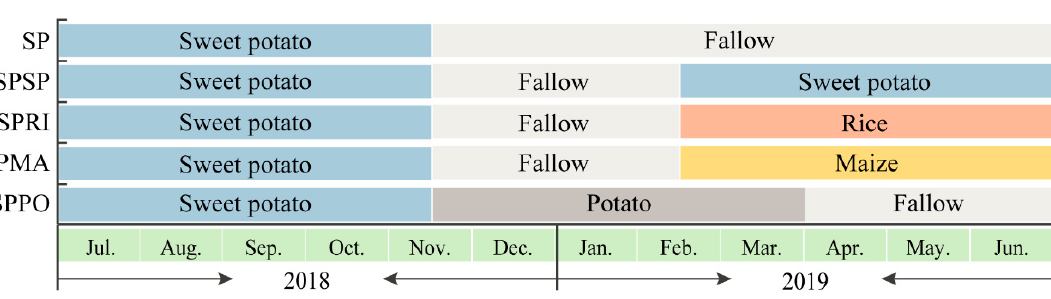
Figure 2. Cultivation time of the five cropping systems within a year. Table 2. Input and output data of five sweet-potato-based cropping systems in Guangdong prov- ince per hectare.